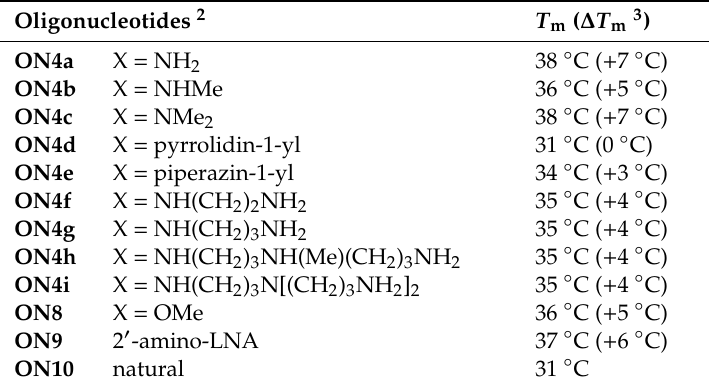
Table 3. T m values of triplexes containing modified oligonucleotides 1 . Oligonucleotides